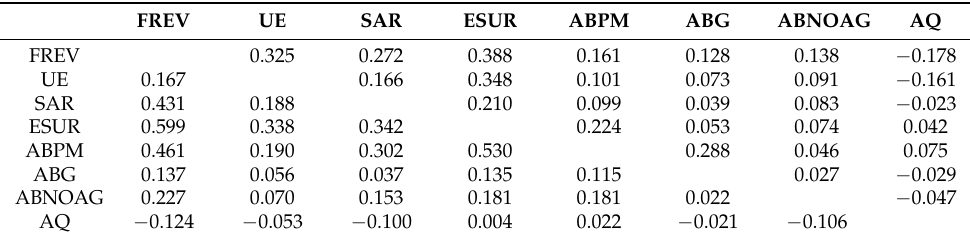
Table 3. Pearson (above the diagonal) and Spearman (below the diagonal) correlations for variables in regressions. a (I suppress the subscripts j, t of each variable in the table). FREV UE SAR ESUR ABPM ABG ABNOAG AQ FREV 0.325 0.272 0.388 0.161 0.128 0.138 − 0.178 UE 0.167 0.166 0.190 0.302 0.530 0.288 0.046 0.075 ABG